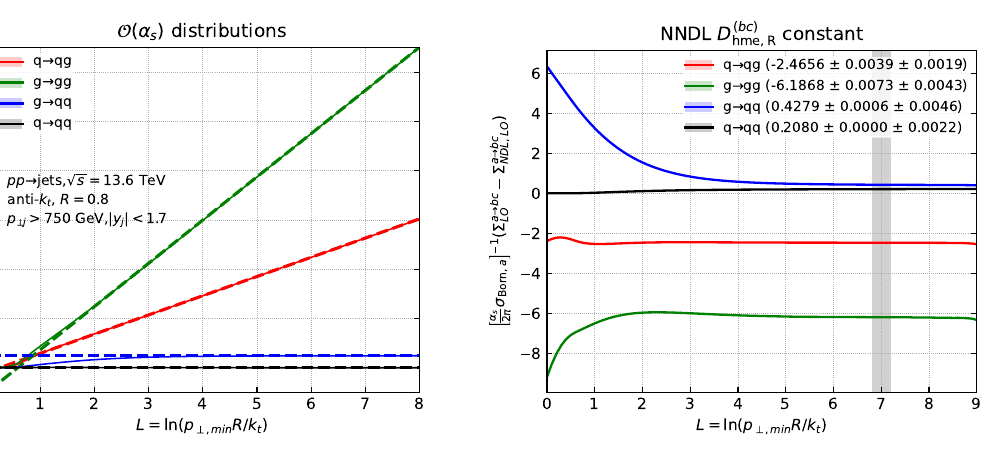
(a) Differential multiplicity distributions, as obtained (b) Extraction of the D ( bc ) asymptotic values. hme ,R from NLOJet++ for the real NLO correction to our These are obtained by integrating the results on inclusive jet sample (solid lines). The dashed lines the left and subtracting the collinear endpoint con- are the NDL expectations. The results are split in tribution ( D end in table 1). The results are again flavour channels. split in flavour channels. coefficients for our inclusive jet sample. Figure 9 . Illustration of the extraction of the D ( bc ) hme ,R uncertainty, and the second number is an estimate of the systematic uncertainties obtained by extracting D ( bc ) at ln( p ) = 6 . 8 and 7.2 and taking their difference. It is delicate R/k t ⊥ hme ,R to comment on the relative size of the various flavour channels as only the full sum in eq. (3.18) is independent of the prescription used to assign